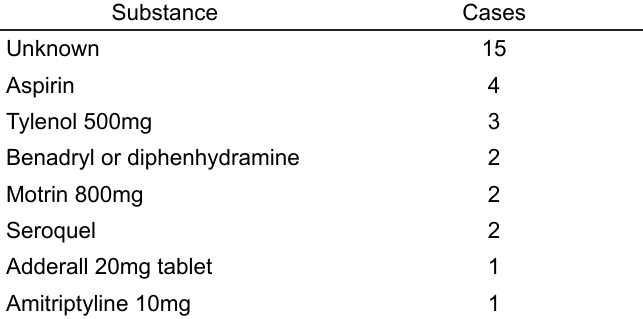
Table 2. Substances reported in death